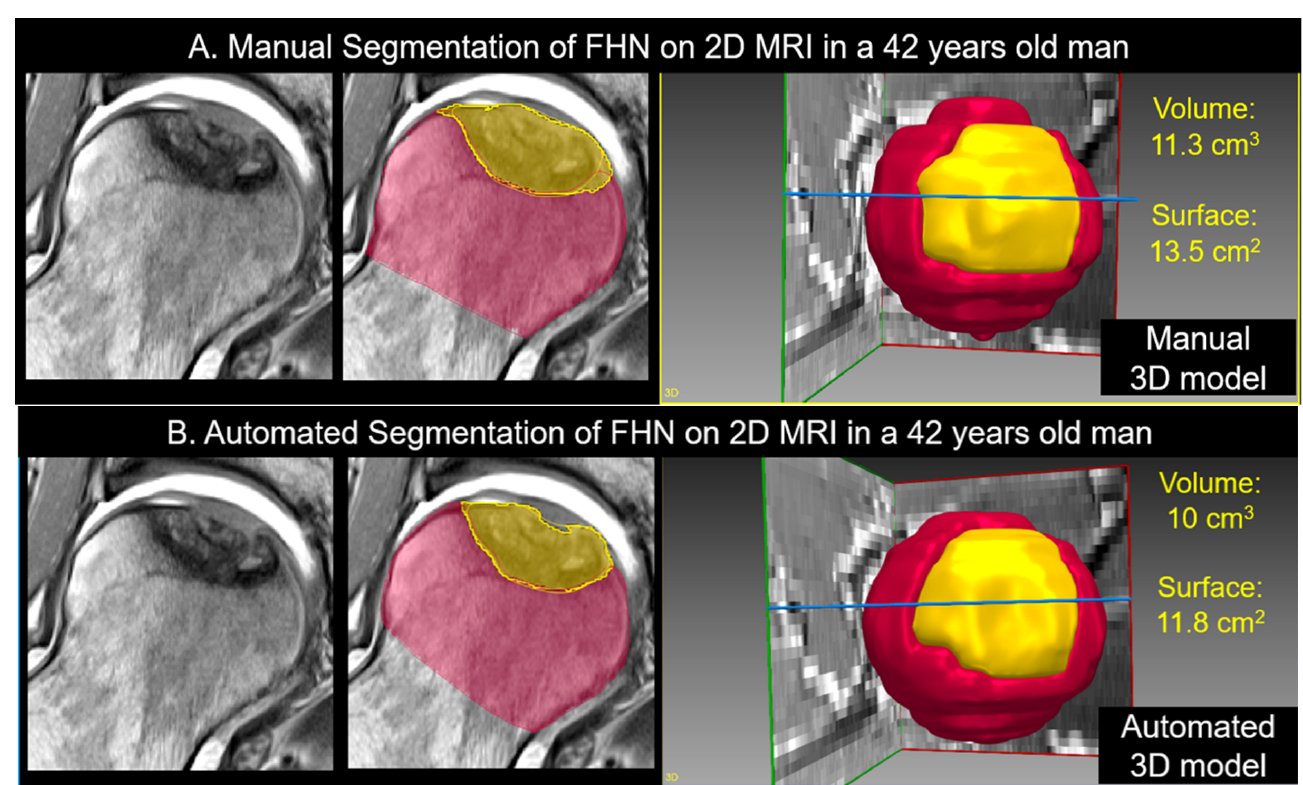
Figure 1. Manual segmentation of femoral head necrosis based on the 3D T1 volume interpolated breath-hold examination (VIBE) sequence is shown. The 3D sequence allows for multiplanar refor- mation for the threshold assisted 3D segmentation of the unaffected bone (red) and the necrotic bone (yellow). In this patient, this yielded a necrotic volume of 9.4 cm 3 and surface area of 11.5 cm 2 .